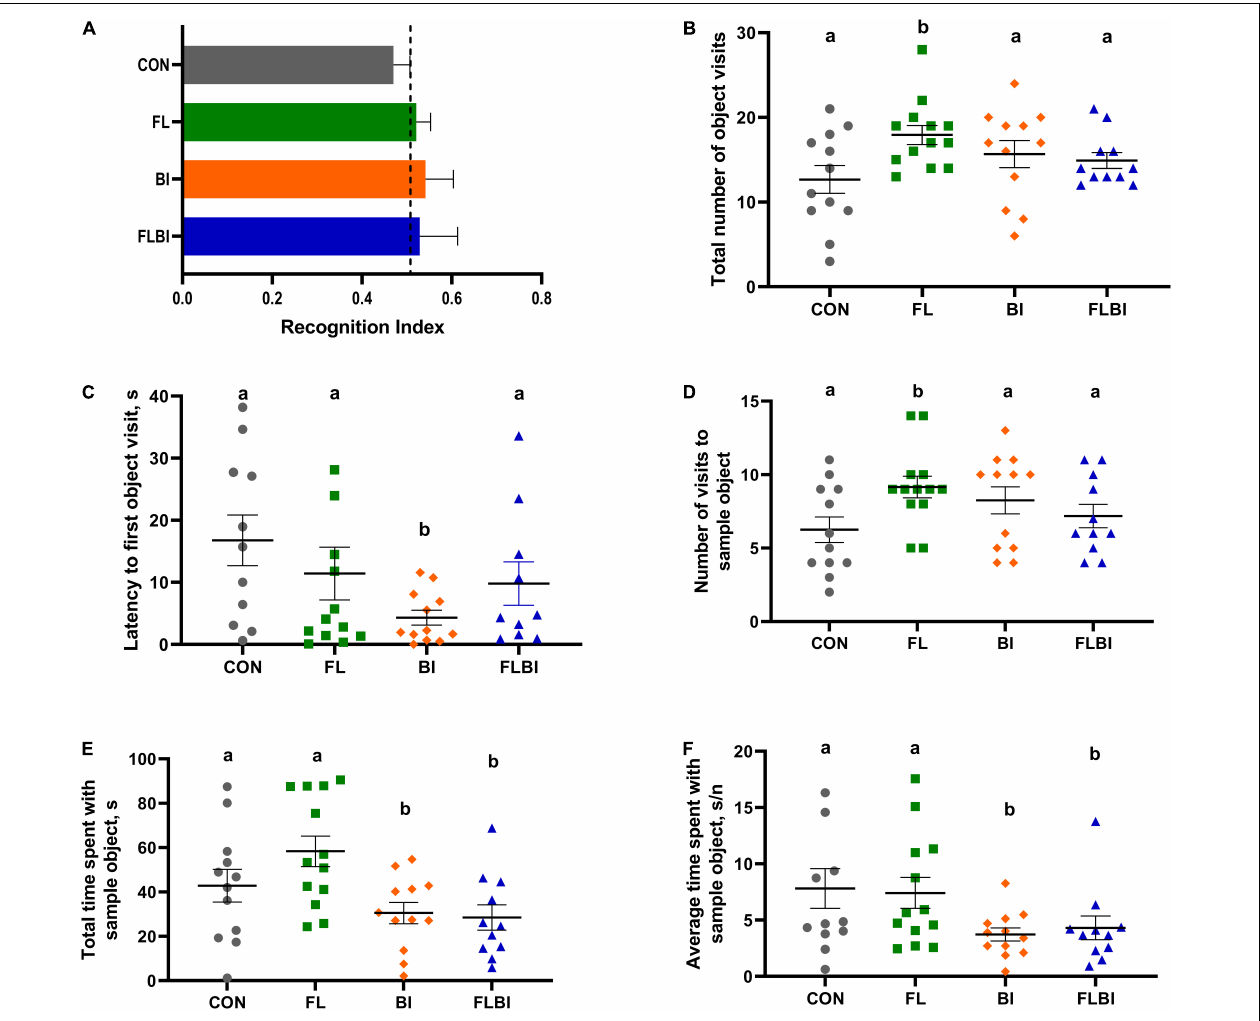
FIGURE 3 | Outcomes from the novel object recognition task. (A) Recognition index during the test trial was used as a measure of recognition memory. The dashed line at 0.50 indicates the chance performance value. No treatment groups exhibited recognition memory ( P > 0.05). (B–F) Object exploratory behaviors were measured. (B,C) Total number of object visits and the latency to the first event of object exploration were reported. The FL group exhibited a higher number of object visits ( P = 0.023), and the BI group showed the shorter latency to the first object visit ( P = 0.023). These effects were not observed in the FLBI group ( P > 0.05). (D–F) Object exploratory behaviors derived from exploring the familiar object were reported. The FL group had a higher number of visits ( P = 0.022), but this effect disappeared in the FLBI group ( P > 0.05). The BI and FLBI groups combined (i.e., the pigs that received Bi-26 supplementation) spent less time exploring the sample object in total ( P = 0.002) and in average per visit ( P = 0.005). Superscript letters (ab) denote differences ( P < 0.05) between the treatment means (i.e., means without a common superscript letter are significantly different). CON, group receiving control diet; FL, group receiving control diet + 1.0 g/L 2 (cid:48) fucosyllactose; BI, group receiving control diet + 10 9 CFU Bi-26/day; FLBI, group receiving control diet + 1.0 g/L 2 (cid:48) fucosyllactose + 10 9 CFU